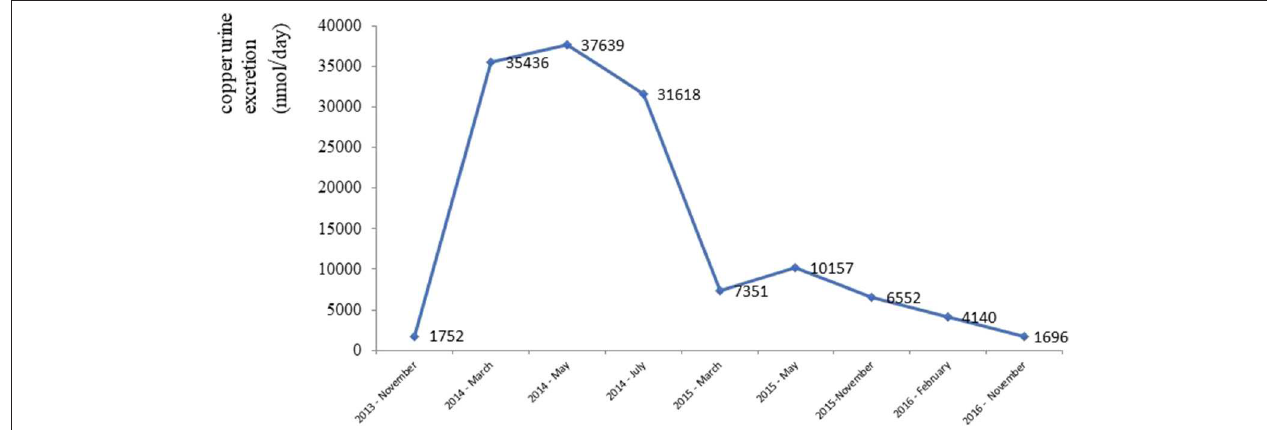
FIGURE 4 | Urine copper excretion during chelating